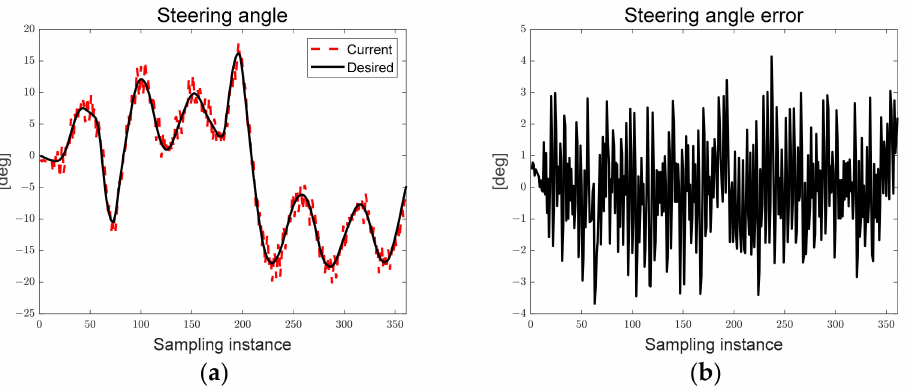
Figure 18. S-curved path tracking scenario results; ( a ) desired and current steering angles; ( b ) steering angle